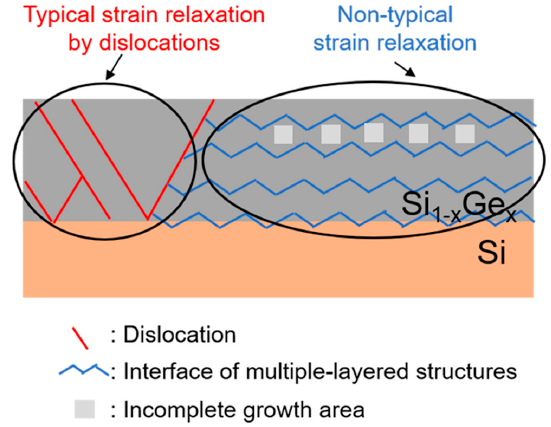
Figure 5. A schematic 2D model of the Si 1 − x Ge x film relaxing strain by typical strain relaxation mechanism (circled on the left) together with the non-typical strain relaxation mechanism (circled on the right).